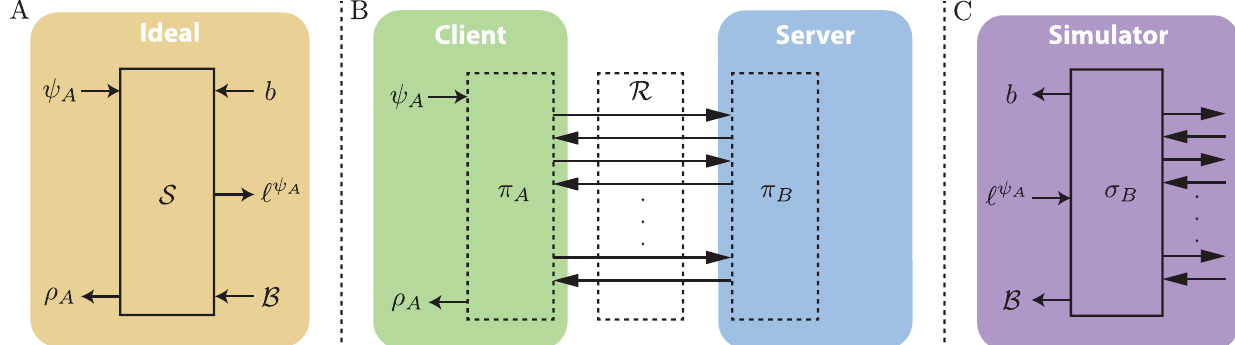
Fig. 1 a A schematic of the ideal resource for blind computation. Here the convention is used that the client ’ s interfaces are on the left, while the server ’ s interfaces are on the right. b A representation of how the two protocols π A and π B are combined with a communications resource ρ R in order to implement a channel mapping ψ A to A . c A schematic of a simulator which can be appended to the right side of ideal resource so that the interfaces of the compound object match those of π A